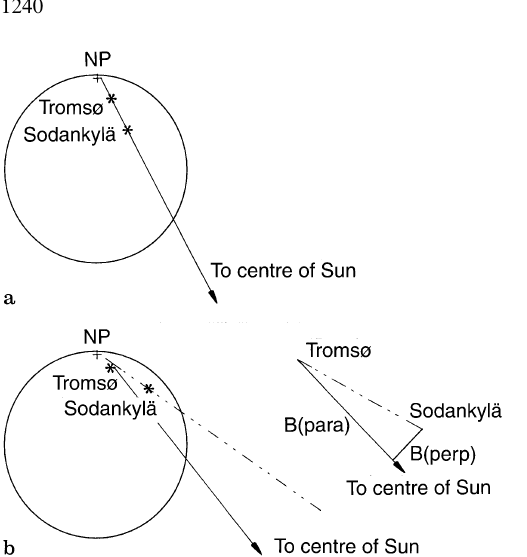
Fig. 7. a The EISCAT antennas viewed from the direction of the source. The transverse separation between the two sites (Troms (cid:249) and Sodankyla¨ ) is zero. NP marks the geographical north pole of the Earth. b The EISCAT antennas viewed from the direction of the source 2 h later than a . The transverse separation between the two sites is no longer zero